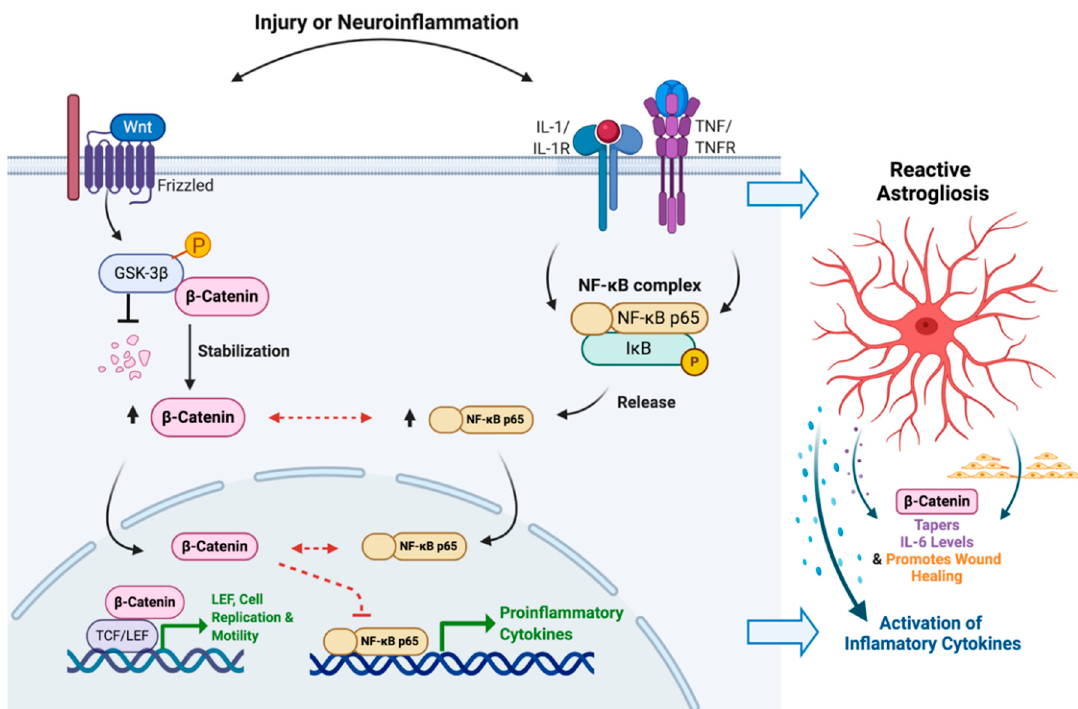
Figure 8. Crosstalk between Wnt/ β -catenin and NF- κ B signaling during HIV-associated inflammation. The HIV-associated inflammatory cytokines IL-1 β and TNF- α upregulated both Wnt/ β -catenin and NF- κ B signaling in human astrocytes. Stabilization of β -catenin significantly improved translocation of both β -catenin and NF- κ B into nucleus (black arrows). Simultaneously, it decreased IL-1 β -mediated expression of IL-6 in astrocytes (dashed red line). In spite of the regulatory overlap between Wnt/ β -catenin and NF- κ B signaling during HIV-associated inflammation, the mechanism (red dashed arrows) of interaction between these two pathways is yet to be decoded in human astrocytes. IL, interleukin; TNF, tumor necrosis factor; R, receptor; GSK, glycogen synthase kinase; NF- κ B, nuclear factor of kappa light polypeptide gene enhancer in B-cells; I κ B, NF- κ B inhibitor; TCF/LEF, T-cell factor/lymphoid enhancer-binding factor. Created with BioRender.com.